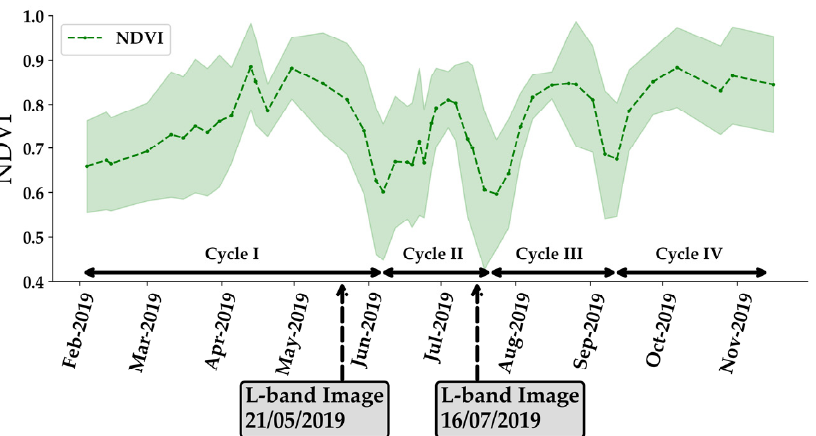
either coarse hay or legume).